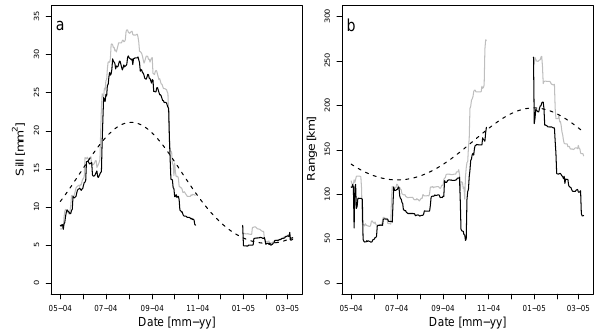
Fig. 10. Parameters of the fitted semi-variograms between March 2004 and March 2005. Left panel is sill and right panel is range of the fitted variogram. The dashed cosines are the estimates from the climatological variogram, the solid black lines are the fits for each day using all KNMI and UU-WUR data, and the solid grey lines are the fits for each day only using the KNMI